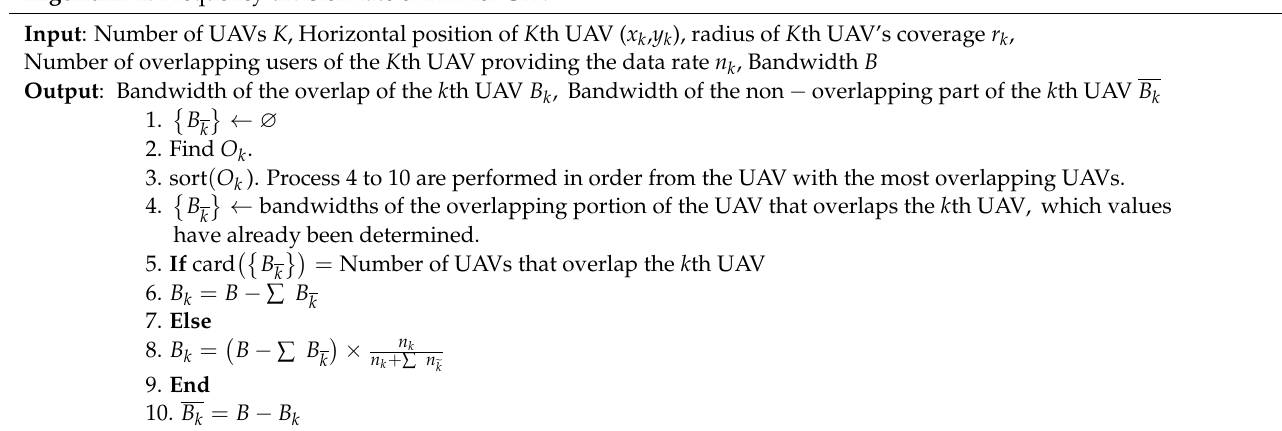
Algorithm 2: Frequency division rate of FFR for UAV